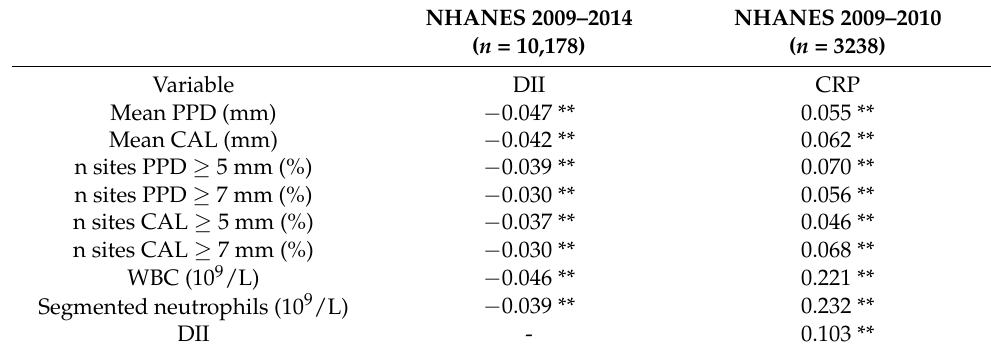
Table 2. Correlation between DII score with periodontal clinical measures, circulating leukocyte levels for the overall sample ( n = 10,178) and C-Reactive Protein for the NHANES 2009–2010 sample ( n = 3238).